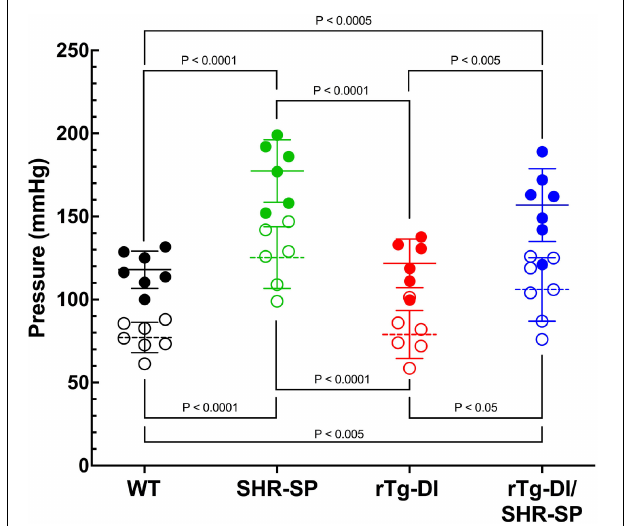
FIGURE 5 | Bigenic rTg-DI rats exhibit elevated systolic and diastolic blood pressure at 10 M of age. Systolic (closed circles) and diastolic (open circles) blood pressure readings were measured in WT (black; n = 7), SHR-SP (green; n = 6), rTg-DI (red; n = 6), and bigenic rTg-DI/SHR-SP (blue; n = 7) rats at 10 M. Mean pressures are represented by solid or hashed horizontal lines ± SD. The systolic blood pressures of SHR-SP and bigenic rTg-DI/SHR-SP rats are significantly increased from those of WT and rTg-DI rats. It is shown by one-way ANOVA that P < 0.0001 for SHR-SP compared to both WT and rTg-DI, P < 0.0005 for bigenic rTg-DI/SHR-SP compared to WT and P < 0.005 compared to rTg-DI. The same differences between groups are shown in diastolic pressures by one-way ANOVA. Comparisons of SHR-SP to WT and rTg-DI both are P < 0.0001. Diastolic pressures of bigenic rTg-DI/SHR-SP compared to those of WT and rTg-DI are P < 0.005 and P < 0.05, respectively. These results indicate that the increase in both systolic and diastolic blood pressures is maintained with addition of the rTg-DI transgene on the SHR-SP